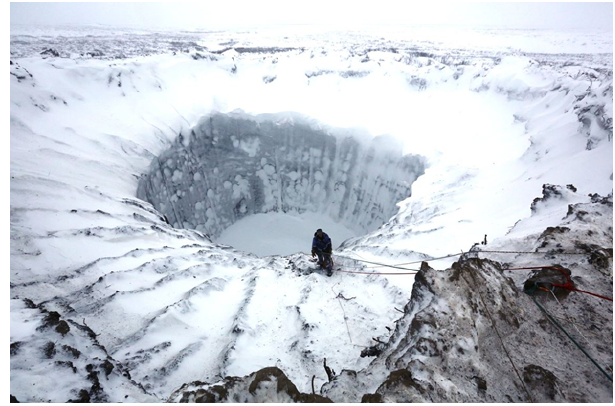
Figure 3. New crater produced by gas explosion on the Ya- mal Peninsula in 2014 (Leybman et al., 2015; photograph by Vladimir